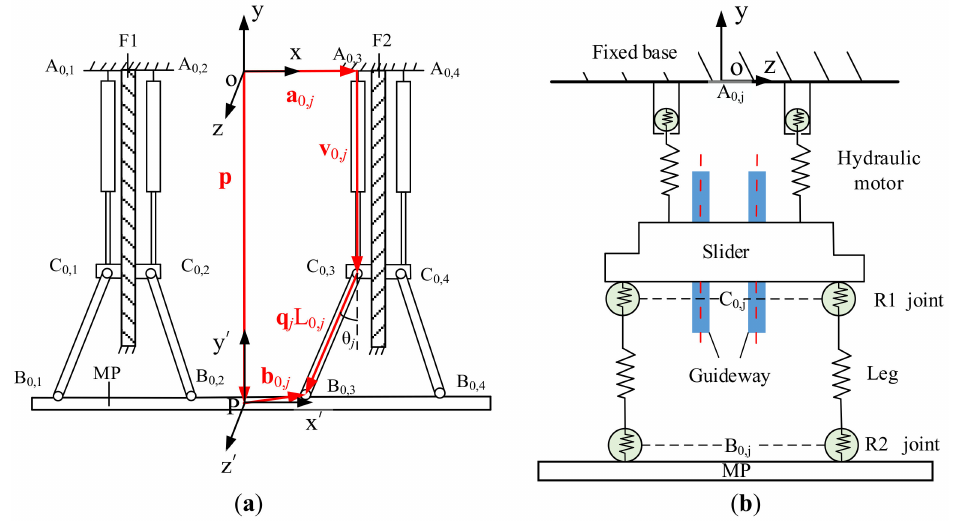
Figure 6. Kinematic models of 4-(2PRR) parallel planar mechanism. ( a ) Kinematic model of the 4-(2PRR) redundant parallel manipulator; ( b ) topology structure of 4-(2PRR) kinematic chain.